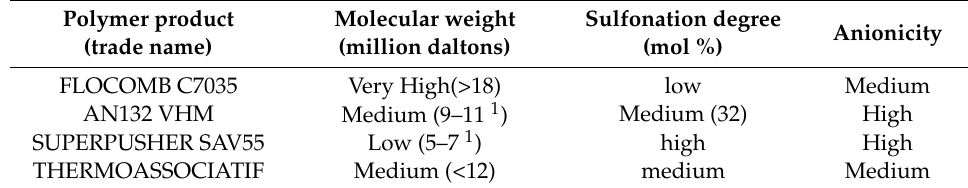
Table 1. Polymer characteristics (extracted from our previous work [4]).